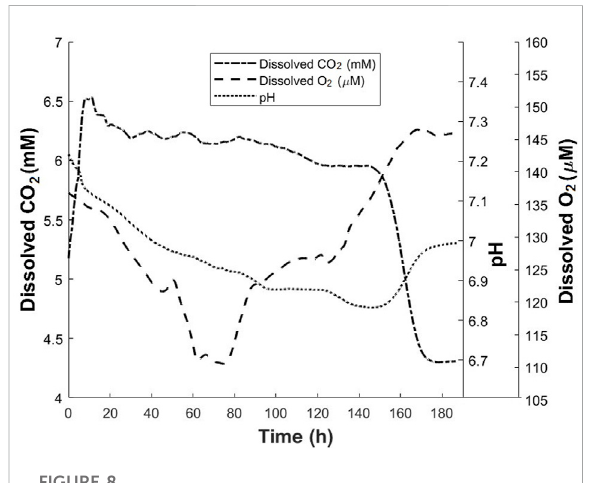
Dissolved CO 2 , dissolved oxygen and pH pro fi les for CHO-K1 culture in modi fi ed T-175 fl ask. The dissolved CO 2 pro fi le was obtained using the proposed